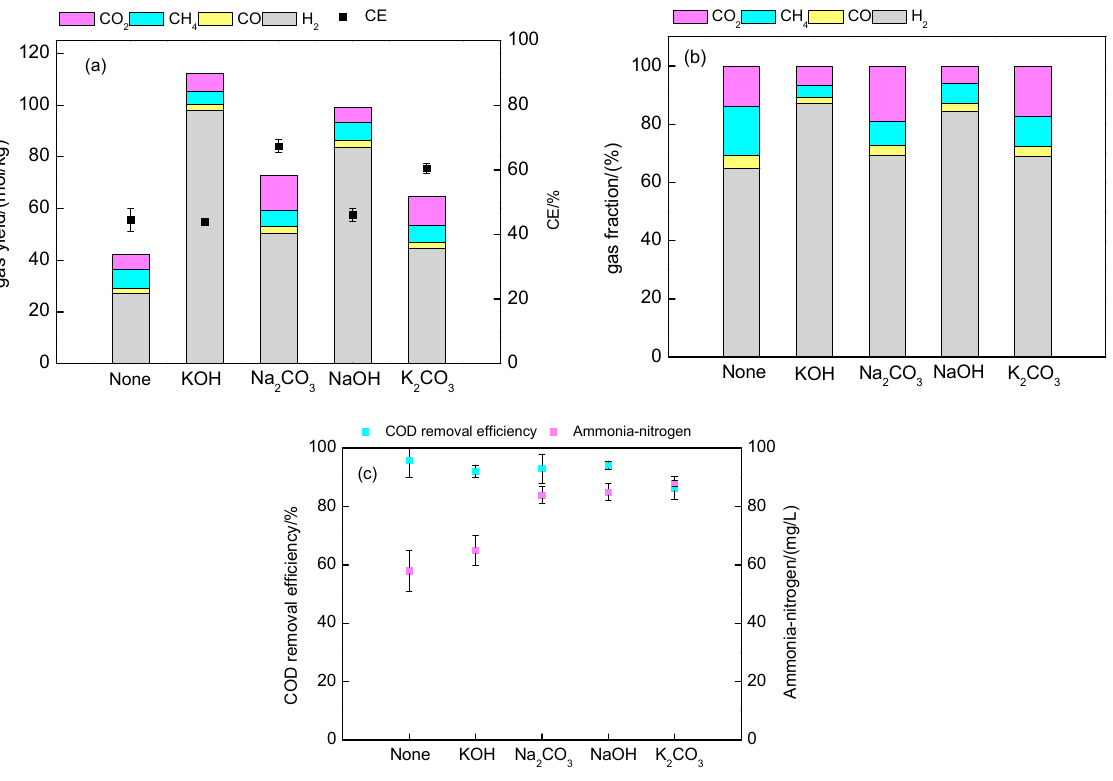
Figure 2. Effect of catalyst on gasification characteristic: ( a ) gas yield and CE ( b ) gas fraction ( c ) COD removal efficiency and ammonia nitrogen (550 °C, 23 MPa, residence time 20 min).